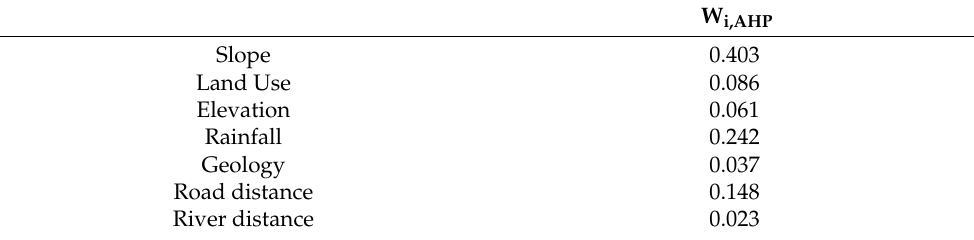
Table 4. Weight of normalized landslide hazard factors through AHP